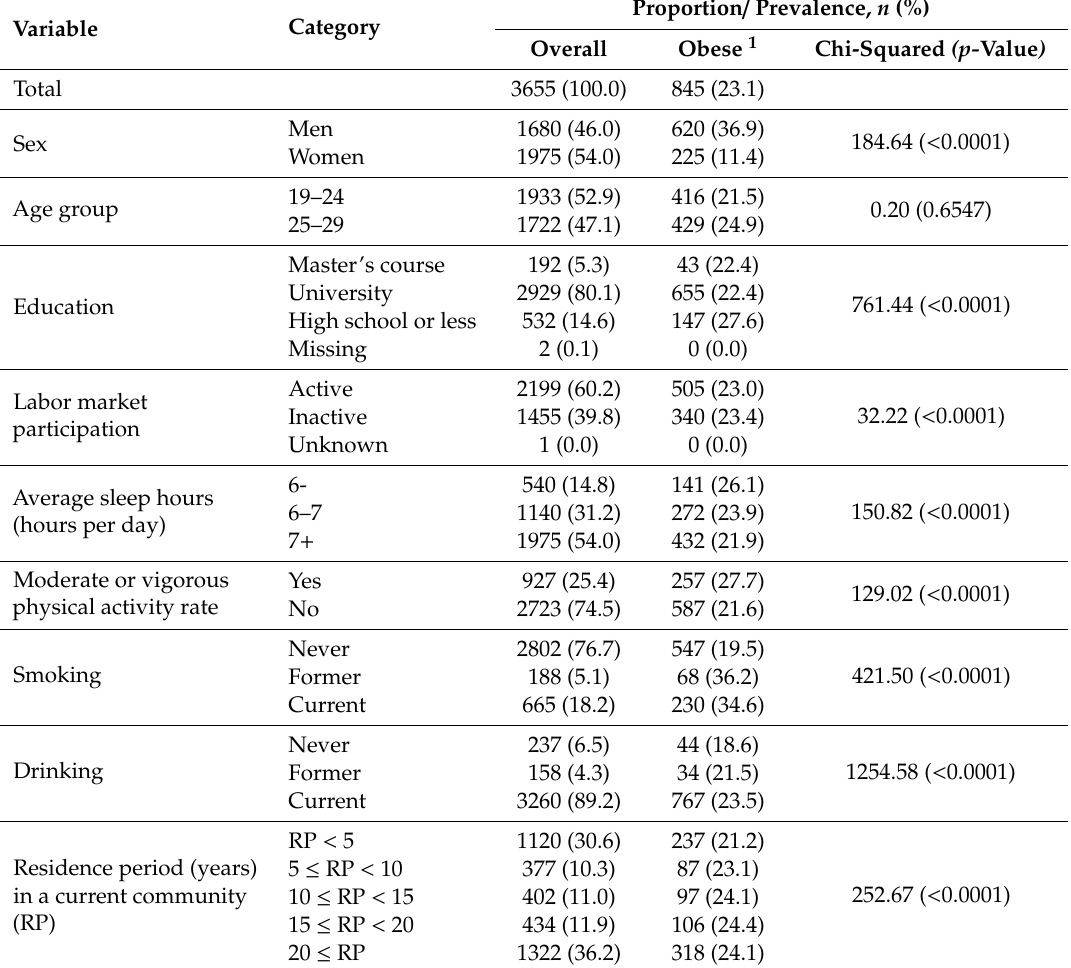
Table 1. Descriptive characteristics and obesity prevalence among the study